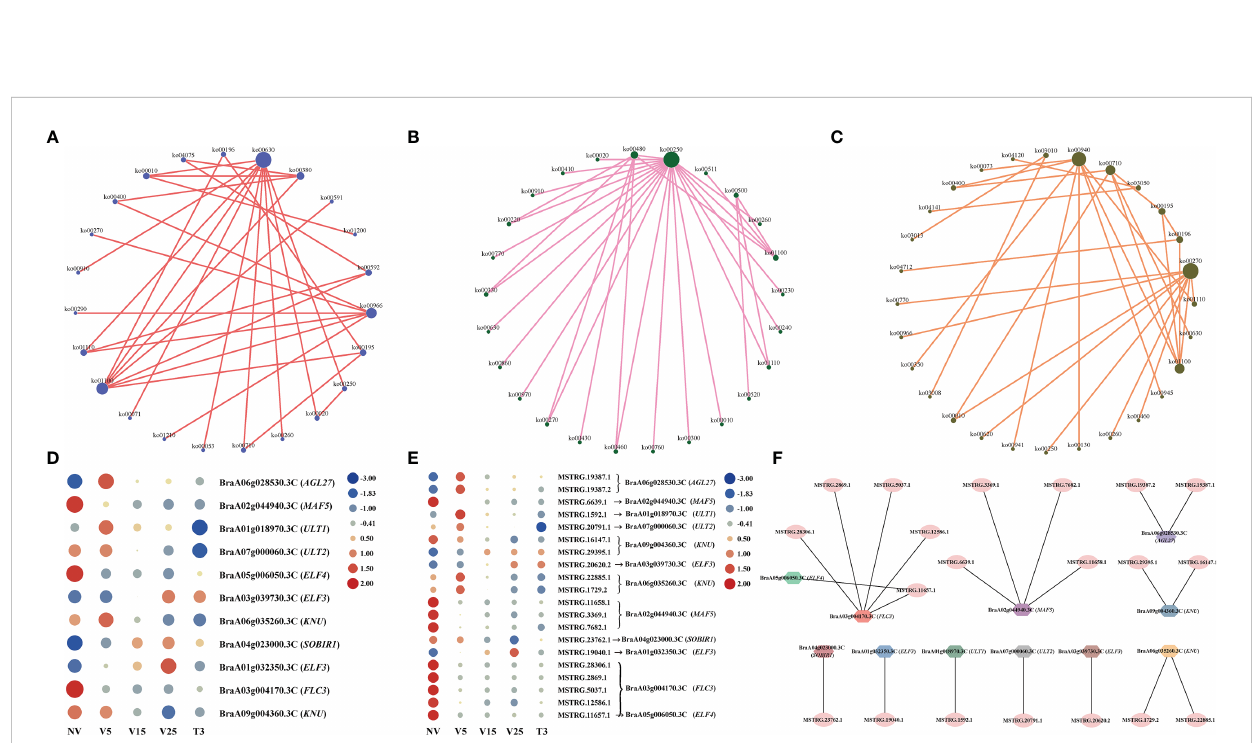
FIGURE 7 Analysis of lncRNAs and their target genes involved in ‘ fl owering. ’ (A) KEGG enrichment analysis of DE lncRNA – anti-regulated genes. (B) KEGG enrichment analysis of DE lncRNA – cis-regulated genes. (C) KEGG enrichment analysis of DE lncRNA – trans-regulated genes. (D) Heat map showing the expression pattern of ‘ fl owering ’ -related genes. (E) Heat maps showing the expression pattern of lncRNA regulating the ‘ fl owering ’ genes. (F) Interaction network between lncRNAs and ‘ fl owering ’ genes.